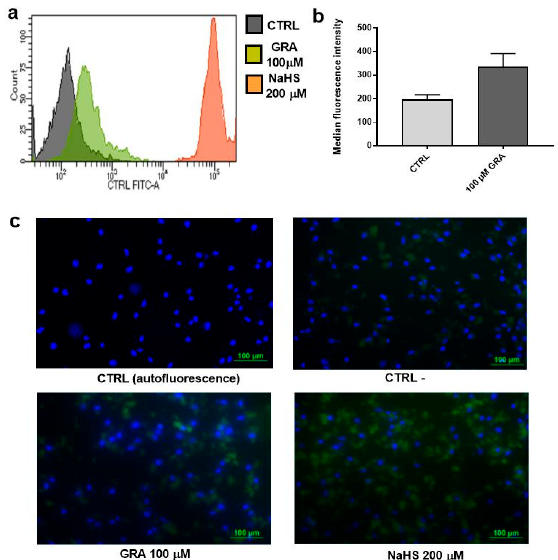
Figure 2. Measurements of intracellular H 2 S levels in hMSCs after stimulation with GRA. ( a ) Histograms showing representative peak fluorescence intensities in GRA-treated hMSCs. Cells treated with 200 µ M NaHS were used as a positive control. ( b ) Histograms showing the median fluorescence intensity in GRA-treated hMSCs vs. CTRL hMSCs ( N = 3 independent experiments). Wilcoxon signed-rank test was performed for the statistical analysis. ( c ) Representative immunofluorescence pictures showing the intracellular H 2 S staining (CTRL = cells without WSP-5; CTRL- = cells labelled with the probe WSP-5, without treatment). Magnification 100×.